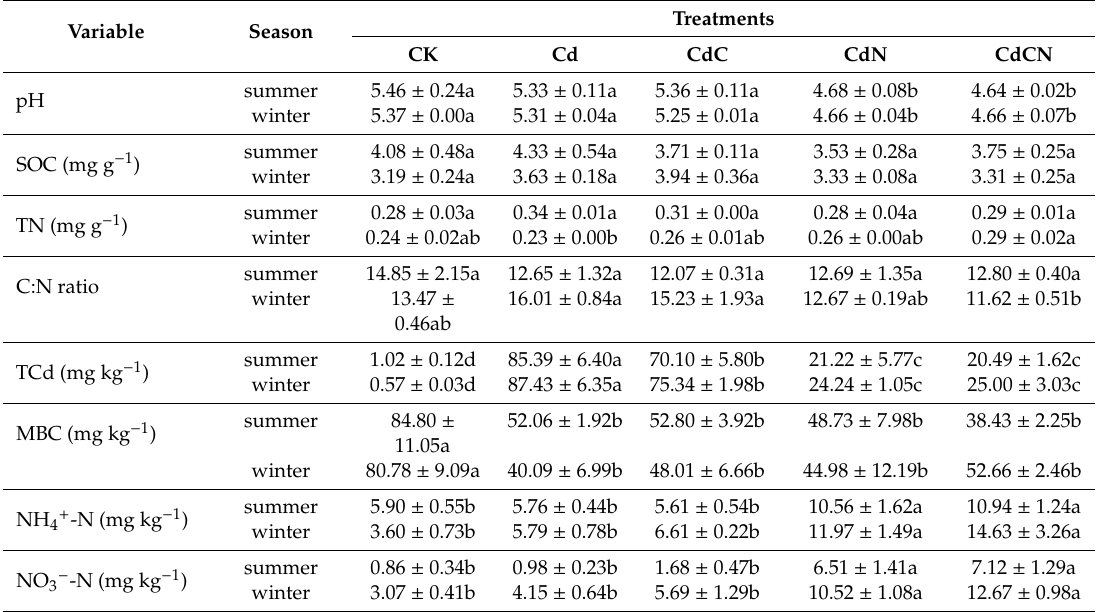
Table 2. Soil properties (0–10 cm depth) in the summer (August 2018) and the winter (February) as a ff ected by the five treatments: CK (the control; with ambient Cd, ambient CO 2 , and ambient N deposition); Cd (with Cd addition, ambient CO 2 , and ambient N deposition); CdC (with Cd addition, elevated CO 2 , and ambient N deposition); CdN (with Cd addition, N addition, and ambient CO 2 ); and CdCN (with Cd addition, elevated CO 2 , and N addition). Values are means ± SE of three replicates. Means in a row followed by di ff erent letters are significantly di ff erent ( p < 0.05) based on a one-way ANOVA followed by an least significant di ff erence (LSD)